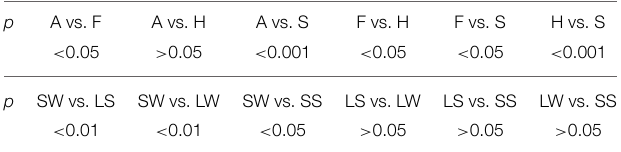
TABLE 3 | Results of Post-hoc Tukey tests on means of the four levels of emotion (A, anger; F, fear; H, happiness; S, sadness) and the four levels of fingerings (SW, small-weak; SS, small-strong; LW, large-weak; LS, large-strong). p A vs. F A vs. S F vs. H F vs. S H vs. S